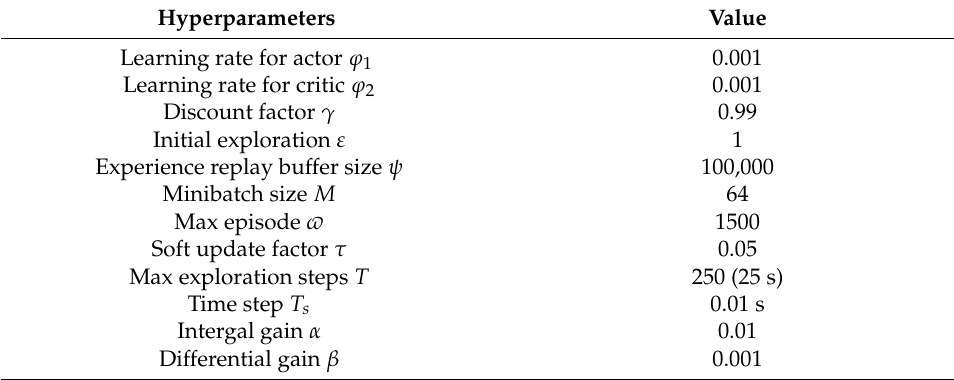
Table 5. Training parameters of DDPG-ID and